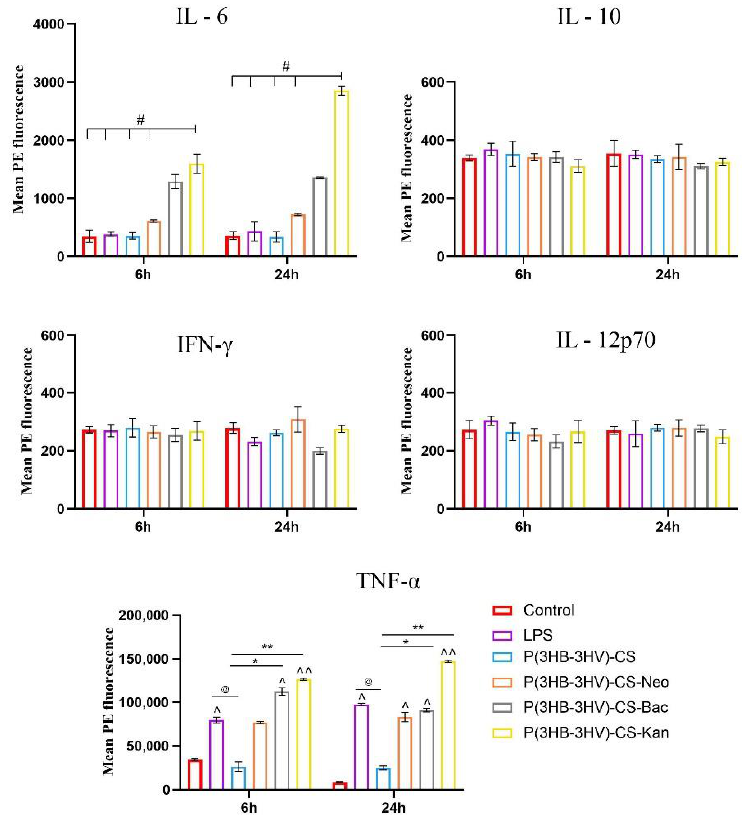
Figure 9. Graphic representation of IL-6, IL-10, IFN- γ , IL-12p70 and TNF- α cytokine levels released by LPS-activated RAW 264.7 macrophages after 6 h and 24 h of exposure to simple and Bac-/Neo- /Kan- loaded P(3HB-3HV)-CS spheres treatment. The experimental control was represented by media samples collected from non-stimulated RAW 264.7 cell cultures (# p ≤ 0.05 P(3HB-3HV)-CS-Kan vs. control and samples; ˆ p ≤ 0.05 and ˆˆ p ≤ 0.01 sample vs. control; @ p ≤ 0.05 samples vs. LPS; * p ≤ 0.05 and ** p ≤ 0.01 samples vs. P(3HB-3HV)-CS). The represented data are the mean values of three independent experiments ± S.D.